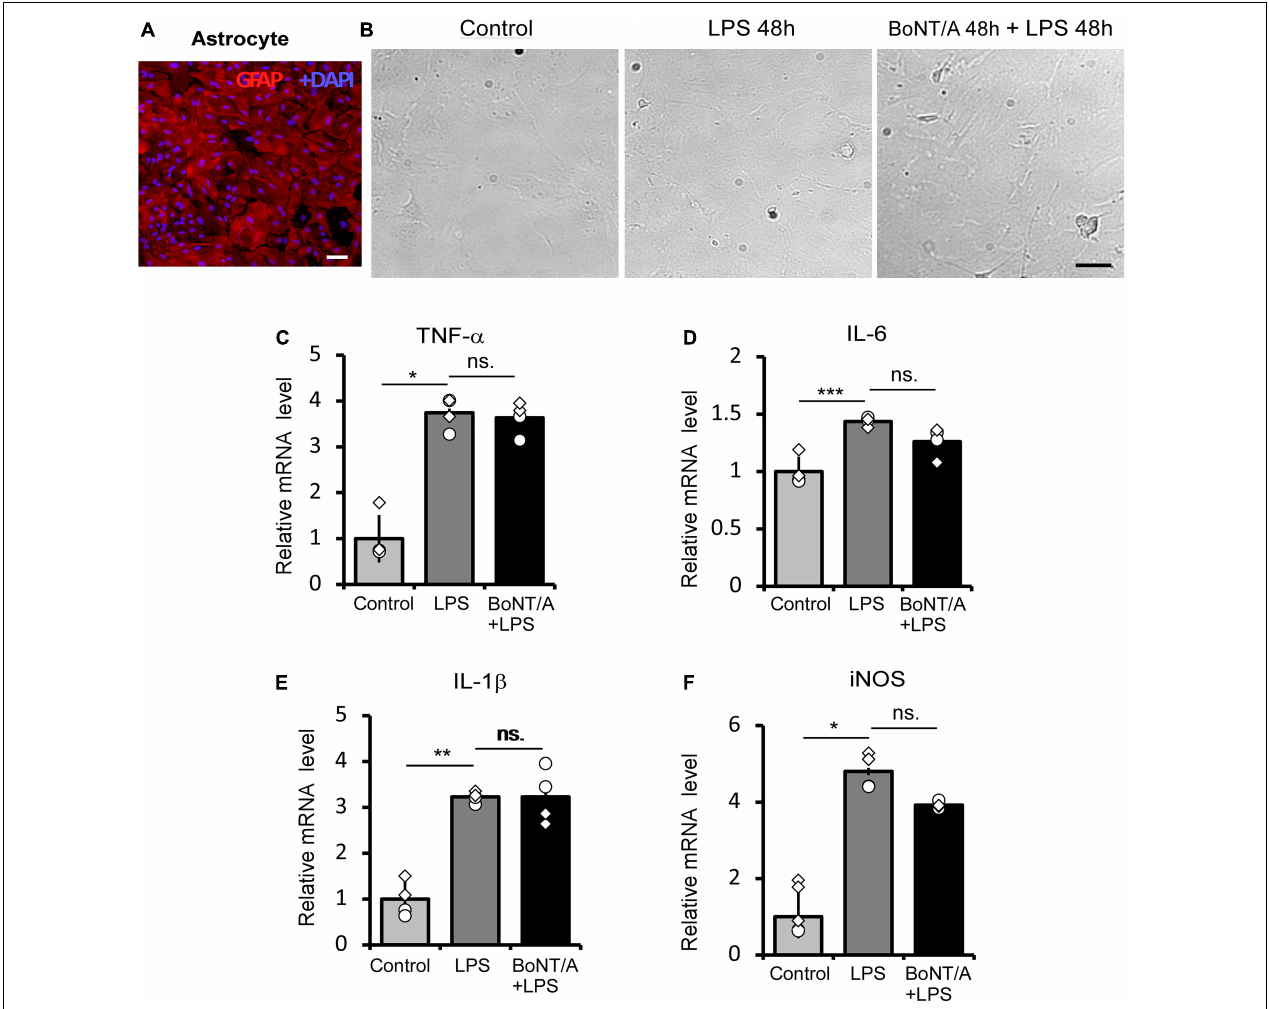
FIGURE 2 | BoNT/A pretreatment does not affect LPS-induced inflammatory cytokine release in primary astrocytes. (A) Image showing double staining with glial fibrillary acidic protein (GFAP, a specific marker of astrocytes, red) and DAPI (blue) in purified astrocytes from the cerebral cortices of newborn SD rats. Scale bar: 200 µ m. (B) Representative morphologies of cultured astrocytes visualized with a phase contrast microscope. Cells were pretreated with or without BoNT/A (2 U/mL) for 48 h prior to incubation with LPS (100 ng/mL) for 48 h. The morphologies of astrocytes with or without LPS incubation show no clear differences. Scale bar: 200 µ m. (C–F) mRNA expression levels of TNF- α (C) , IL-6 (D) , IL-1 β (E) , and iNOS (F) relative to β -actin. BoNT/A pretreatment did not affect the LPS-induced upregulation of mRNA levels of TNF- α , IL-6, IL-1 β , and iNOS. Data are presented as the fold change compared to the control group (without any treatment). Three independent experiments were performed with 2 replicates for each experiment. Data are represented as the mean ± SEM. A non-parametric two-tailed t -test was used for comparison. *** p < 0.001, ** p < 0.01, and * p < 0.05 compared to the control group, ns. = no